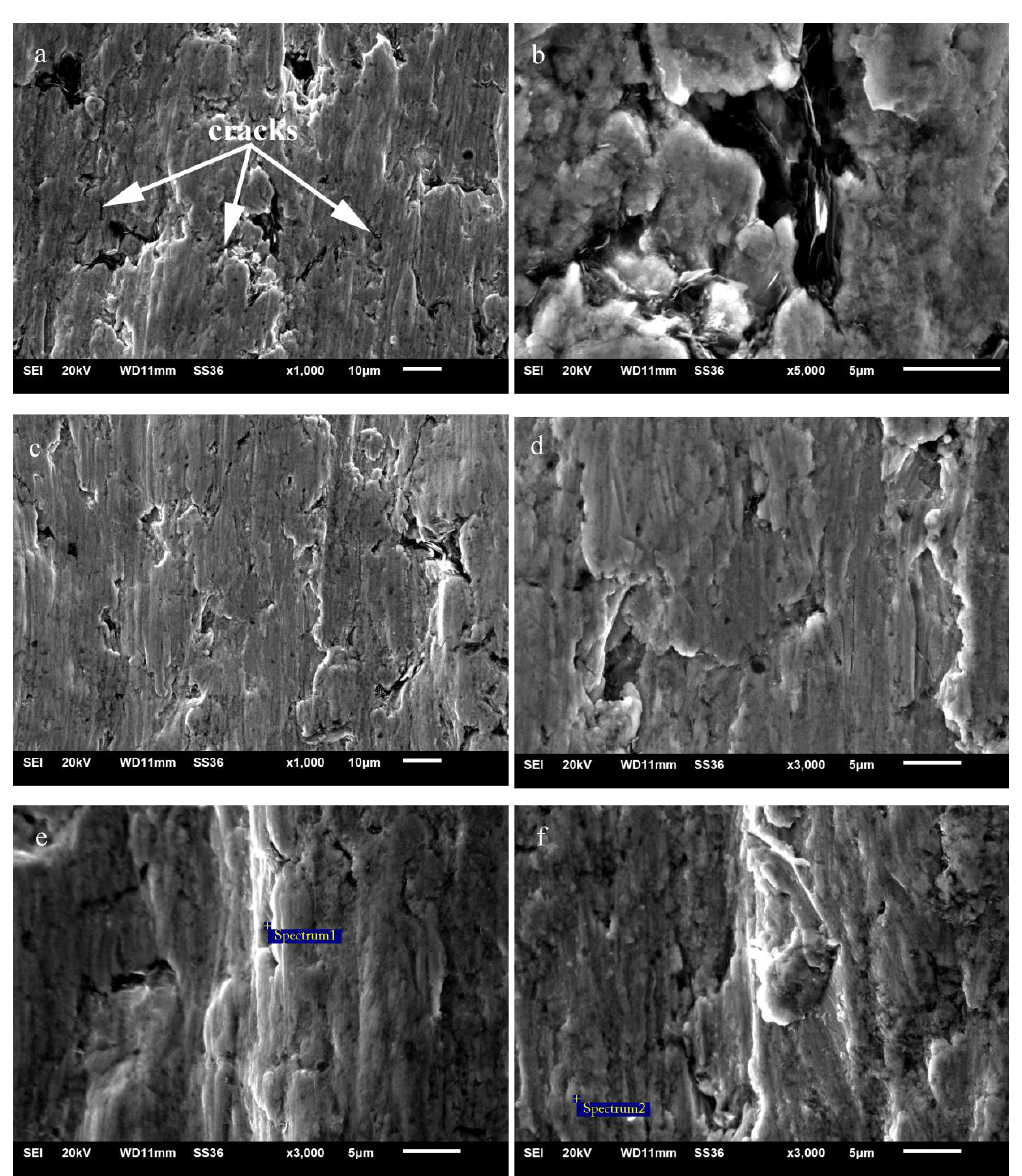
Figure 9. ( a ), ( c ), ( e ) and ( f ) SEM of worn surfaces; ( b ) and ( d ) the partial enlarged picture of ( a ) and ( c ) respectively. Table 3. EDS patterns of spectra 1,2 in Figure 9e,f, respectively.